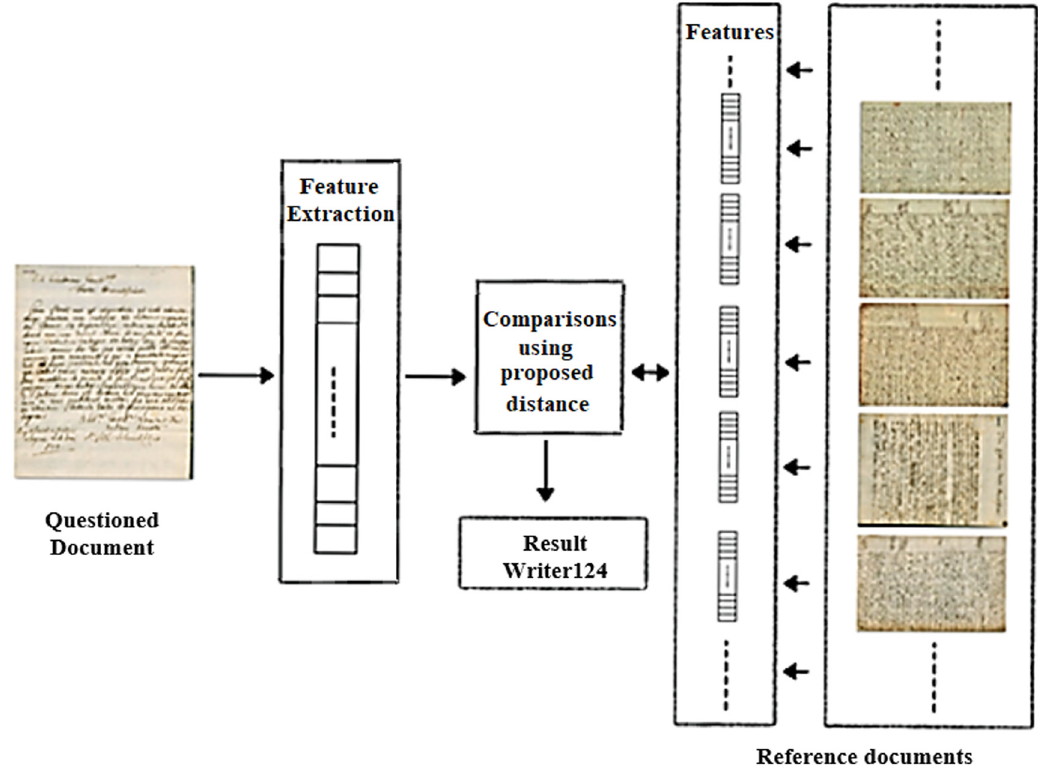
Figure 1: An overview of the proposed writer identi fi cation